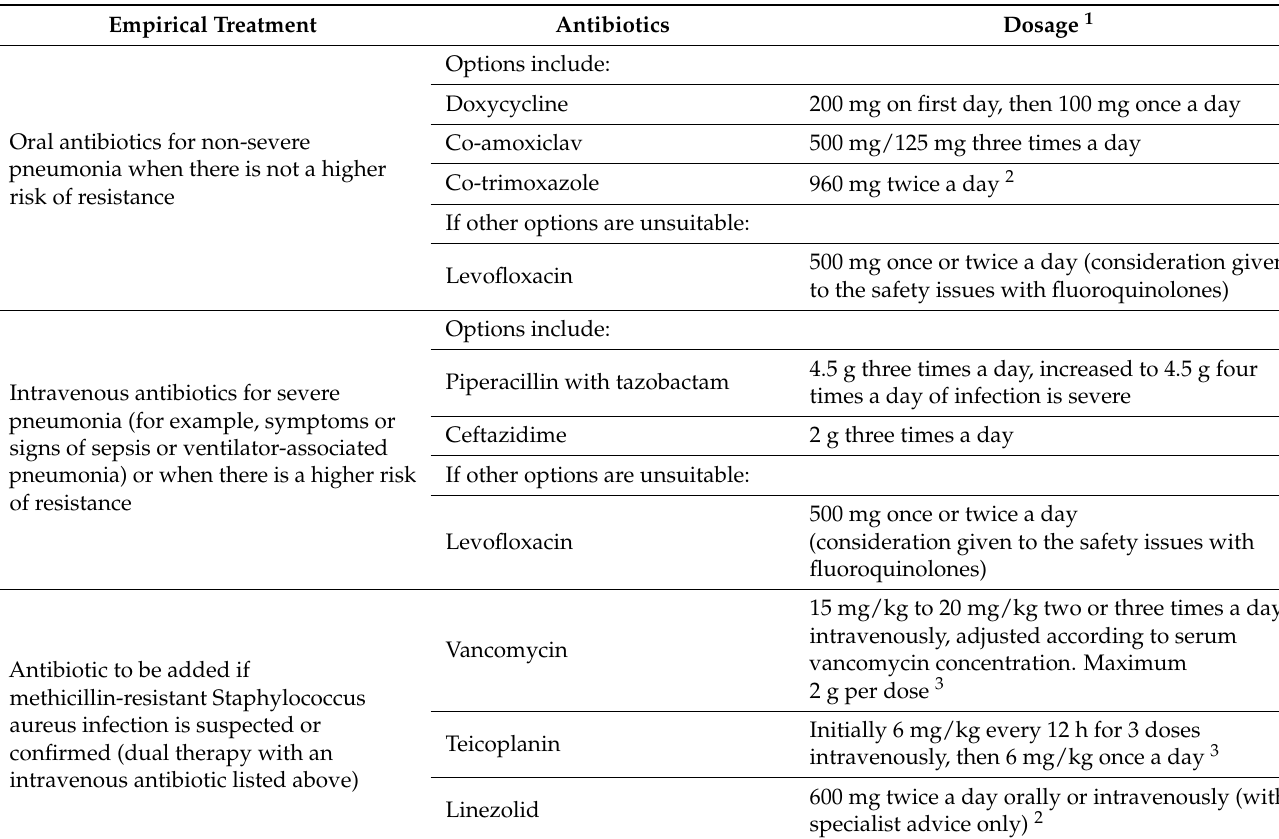
Table 3. NICE Guidelines for Antibiotic use for people older patients aged 18 and older with suspected hospital-acquired pneumonia (adapted from ref.